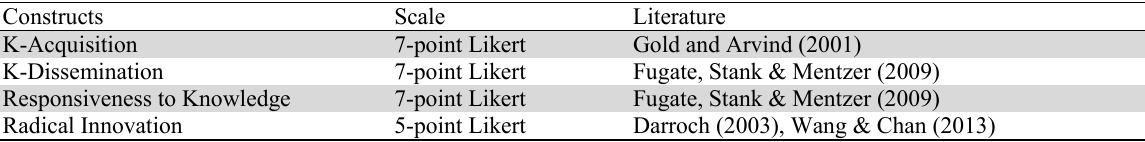
Measurement scales and